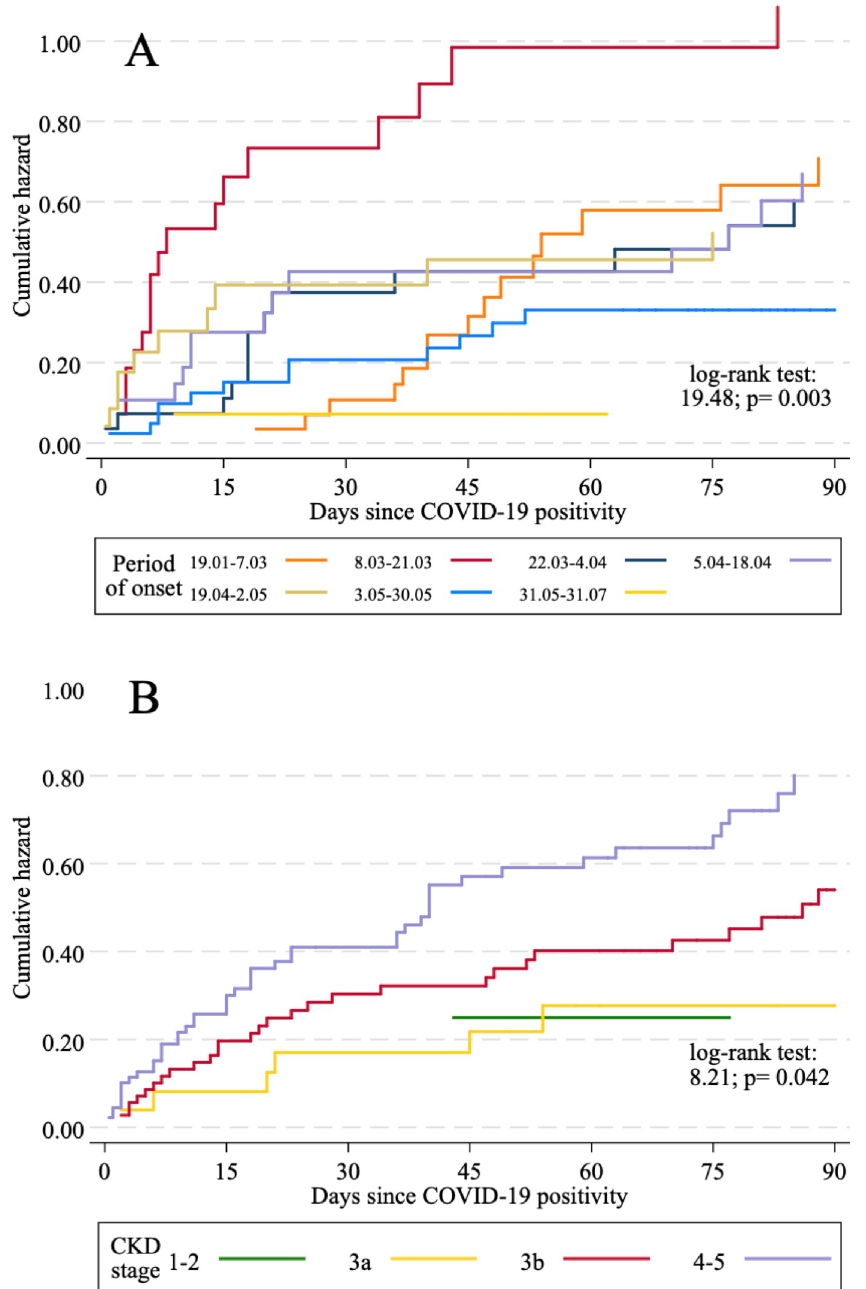
Fig 1. Cumulative hazards of COVID-19 related mortality. (A) By period of onset of the disease. (B) By CKD